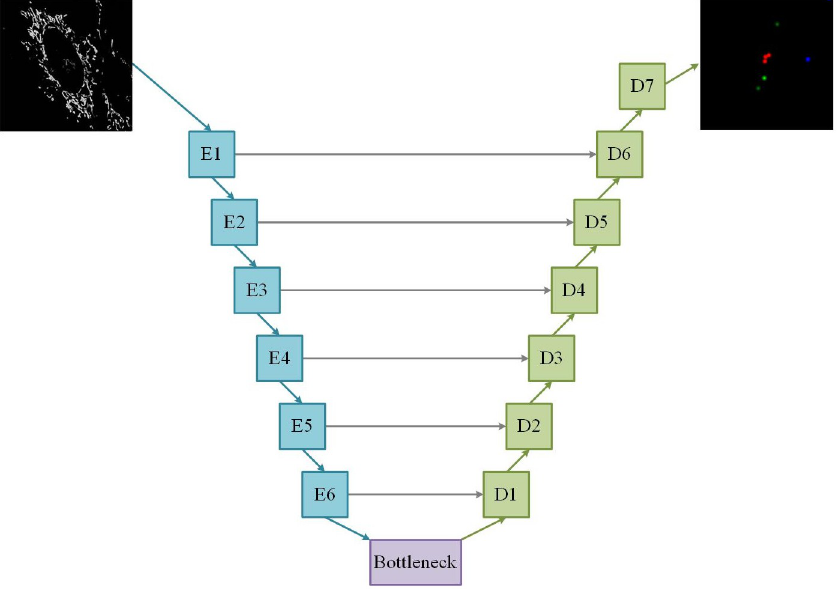
Fig 4. The Pix2Pix GAN generator architecture. The generator is constructed from six encoder blocks ( E ) and seven decoder blocks ( D ). A single frame from a time-lapse sequence is encoded to a lower-dimensional latent vector (bottle- neck), which is decoded to an z-stack containing the locations of mitochondrial events. The horizontal arrows represent skip connections.